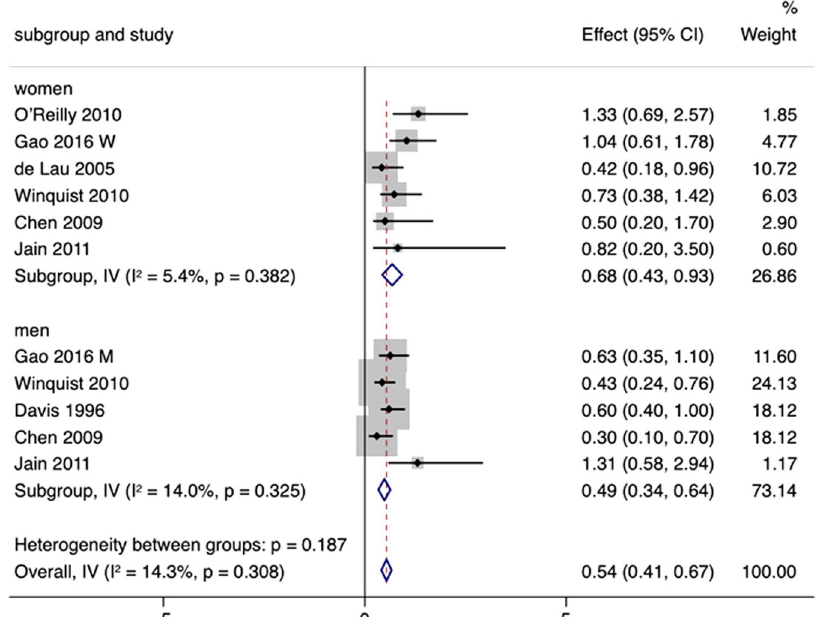
Fig. 4 Subgroup analyses by sex on the correlation between urate concentration and PD risk. RRs were 0.68 (95% CI 0.43 – 0.93) in females and 0.49 (95% CI 0.34 – 0.64) in males.